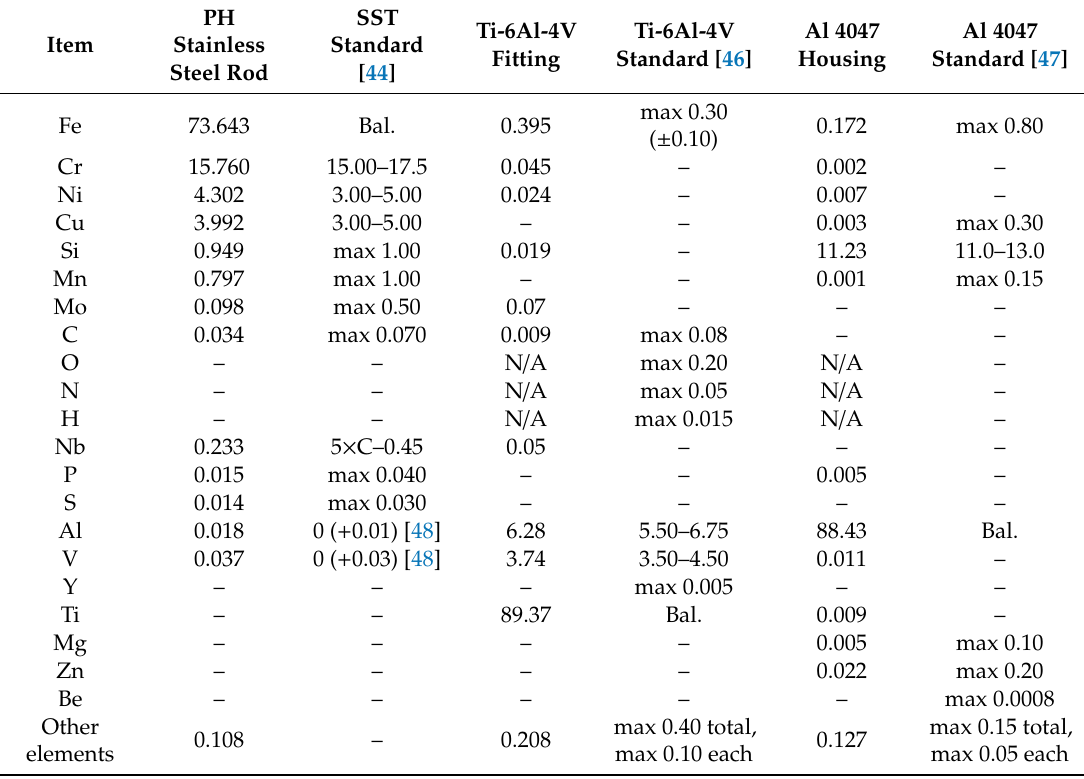
Table 2. Chemical analysis of the printed items (wt.%) in comparison to standard requirements for the equivalent wrought